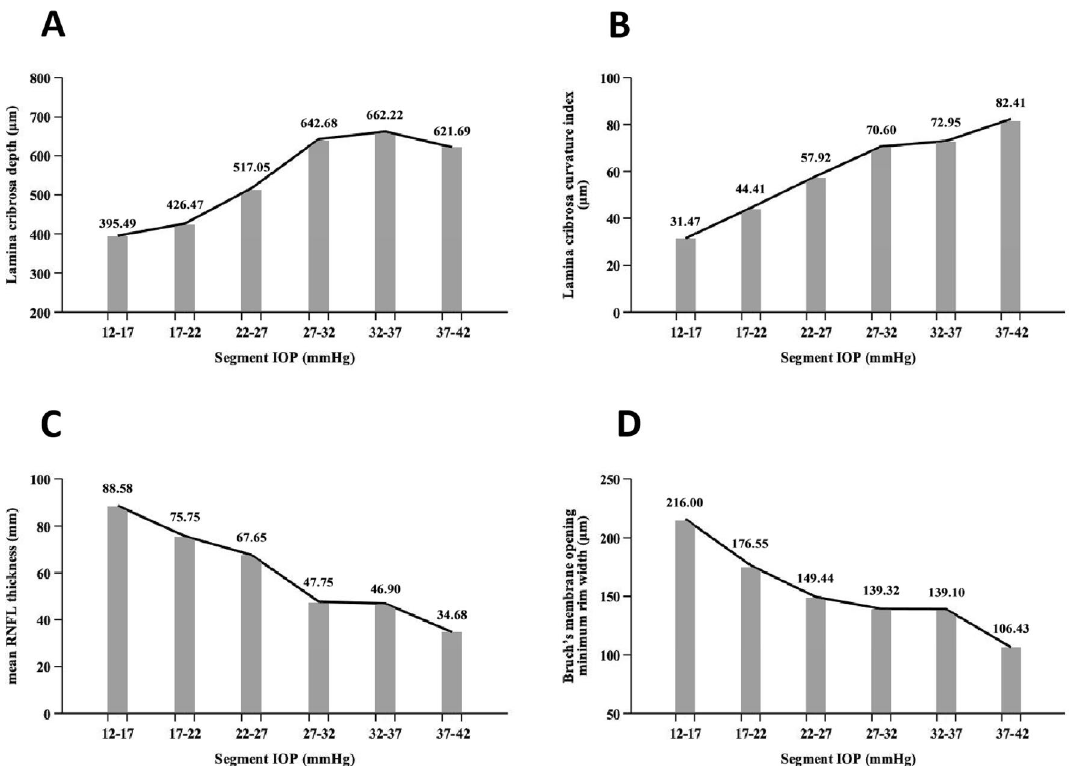
Figure 5. Variation trend of lamina cribrosa parameters under different IOP segments ( A – D ) showed the change trend of LCD, LCCI, mRNFLT and BMO-MRW under different IOP segments. It can be seen that LCD gradually presents a gentle development trend with the increase of IOP level, while LCCI will still increase with the increase of IOP. At the same time, according to the change trend of mRNFLT and BMO-MRW, the corresponding relationship between LCCI and these two indicators reflecting the changes of optic nerve layer seems to be more representative than